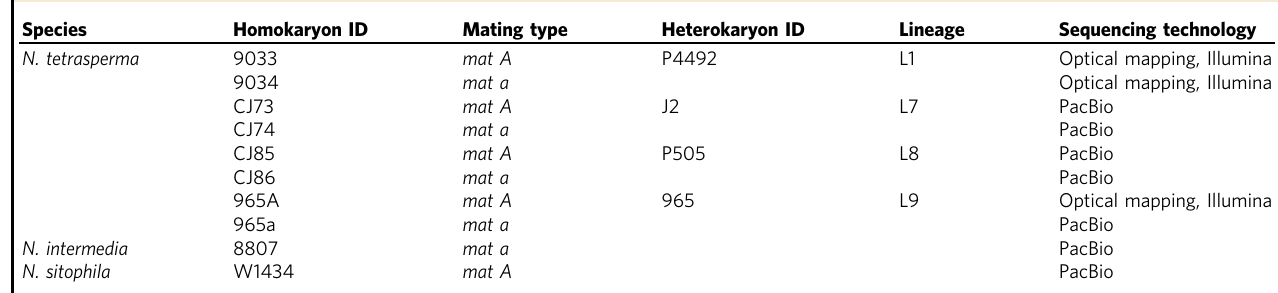
Table 1 Strains sequenced for this study Species Homokaryon